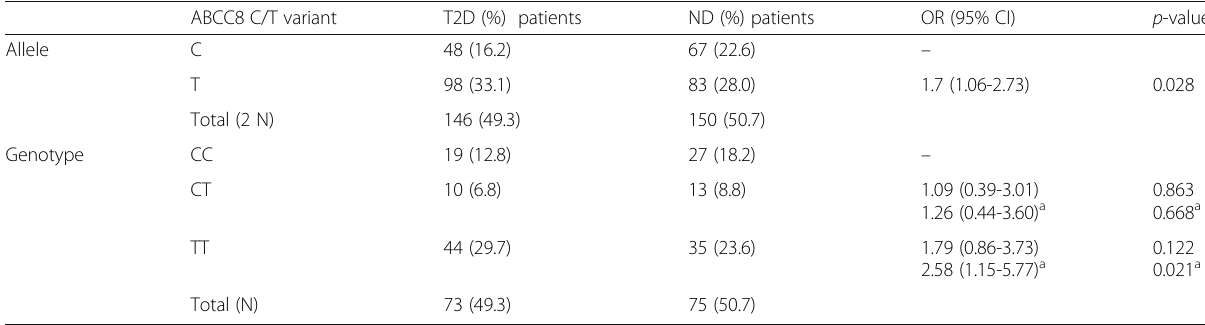
Table 1 Association of ABCC8 C/T alleles and genotypes in participants ABCC8 C/T